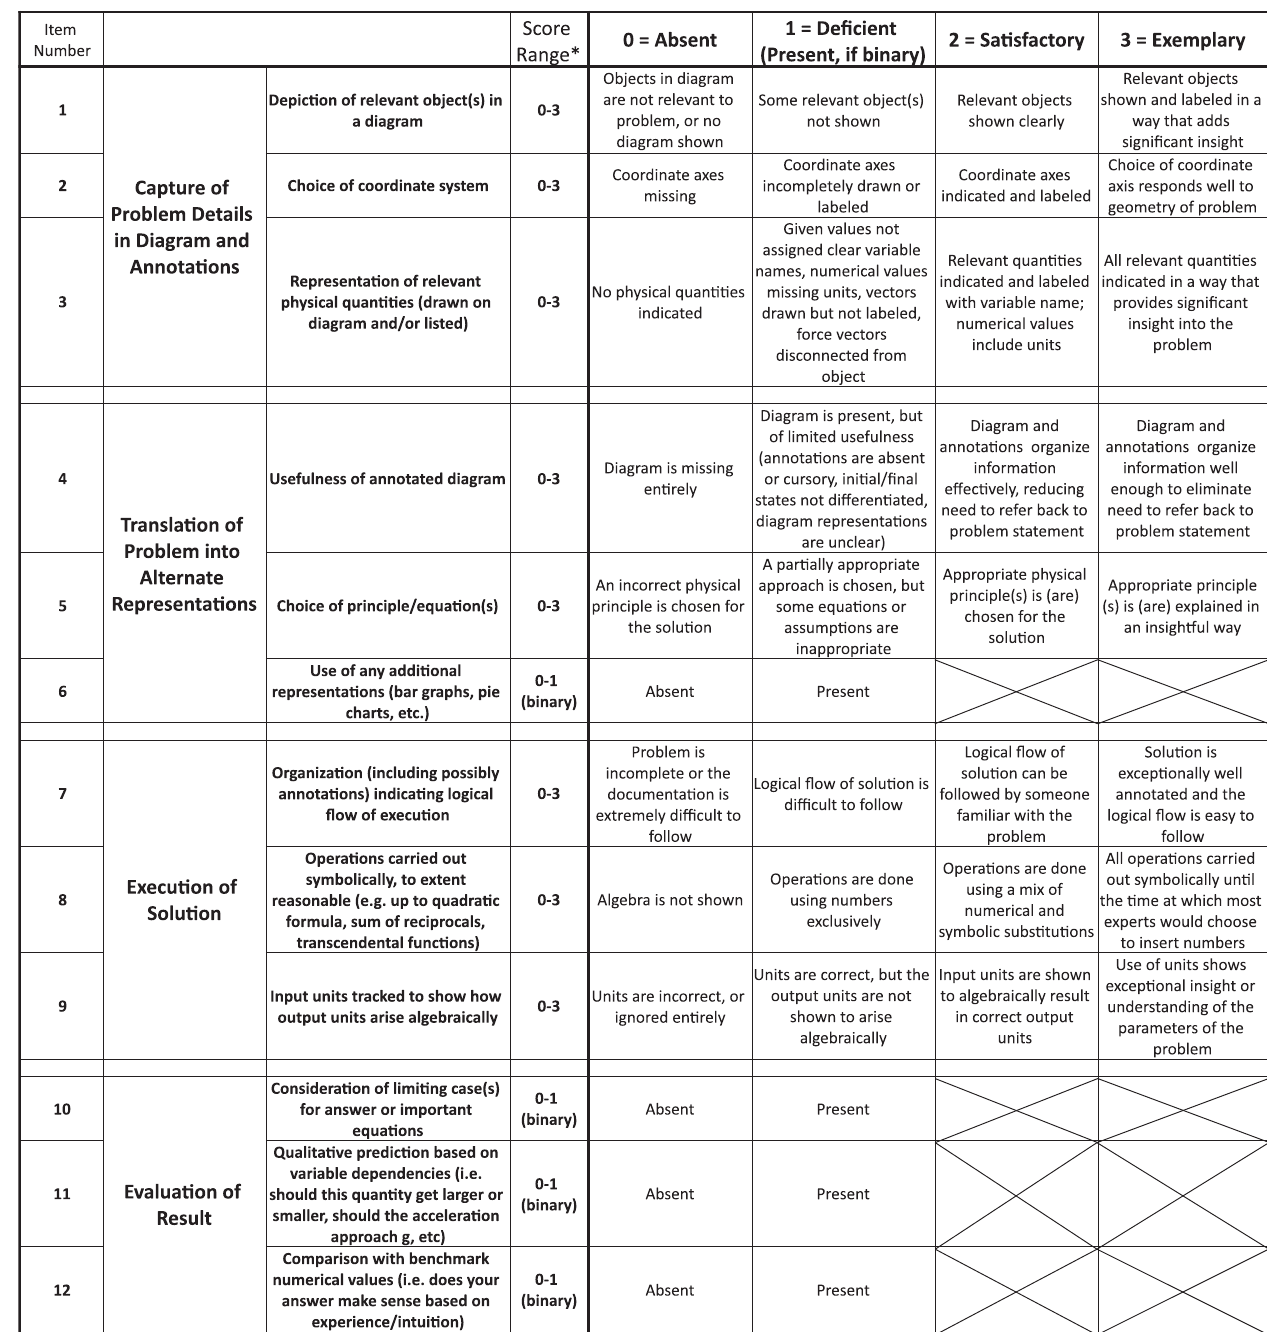
FIG. 2. Rubric used to assess student use of problem-solving best